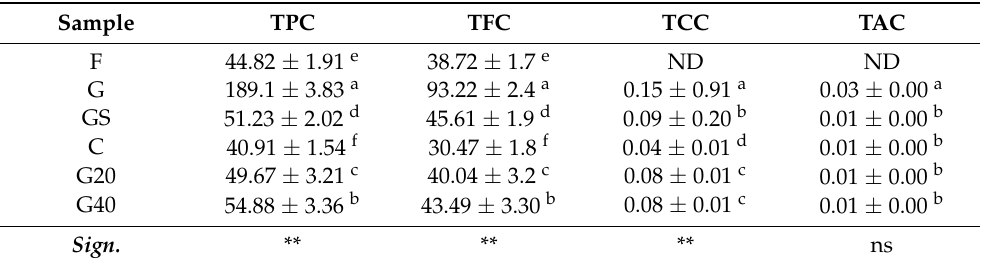
Table 4. Phytochemical content of flour, goji fresh flesh puree, processed goji flesh puree, ciabatta bread, and goji-functionalised ciabatta bread extracts.